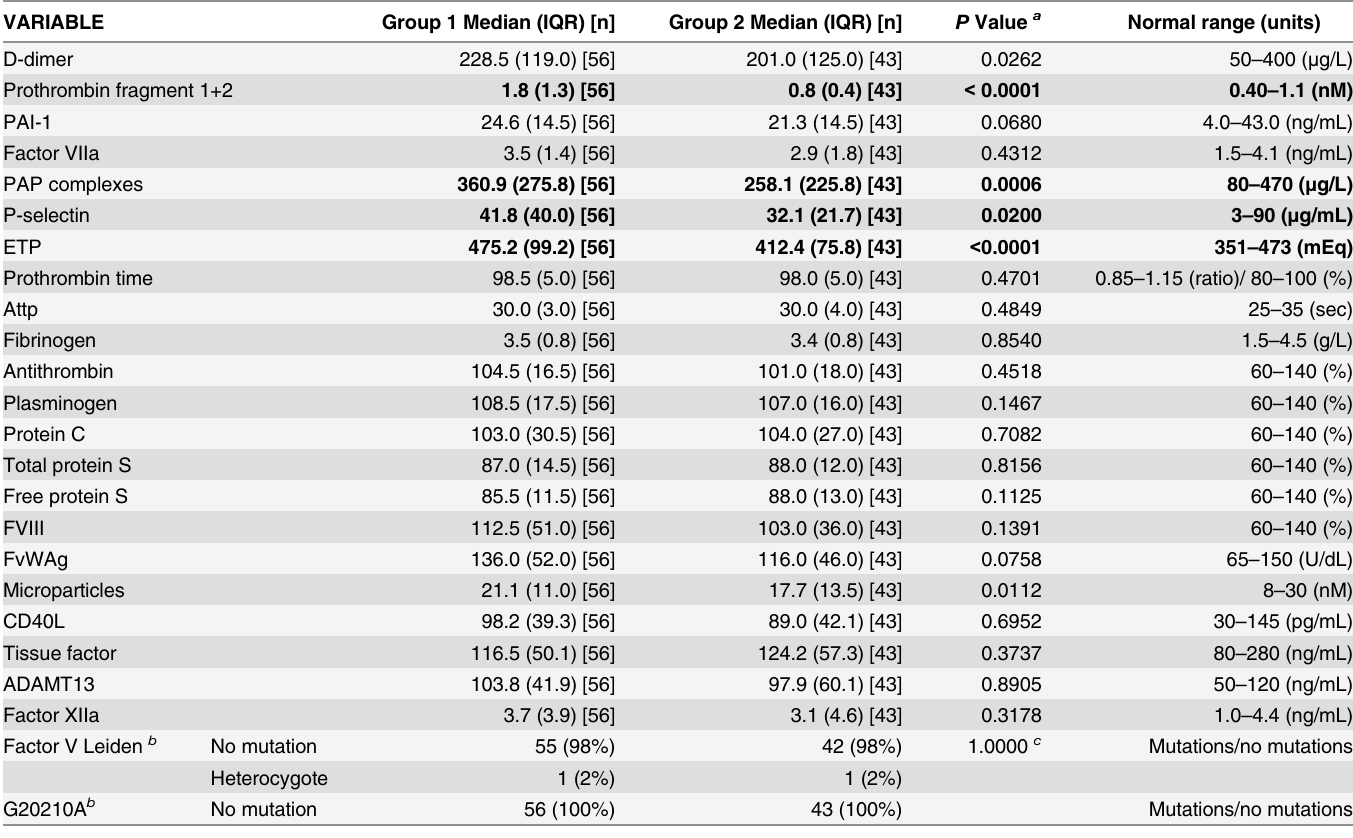
Table 2. Descriptive analysis and comparisons of hemostasis parameters between pretreatment Group 1 (N = 56) and Group 2 (N =